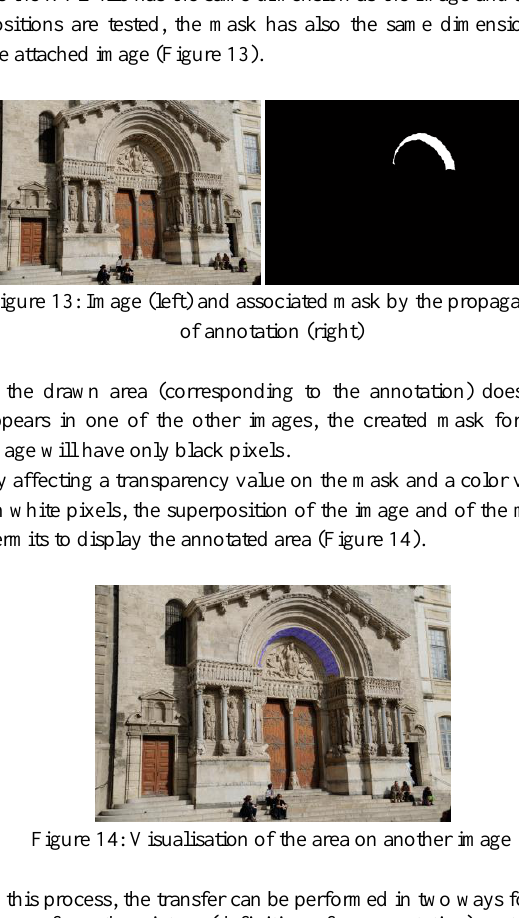
the attached image (Figure 13).